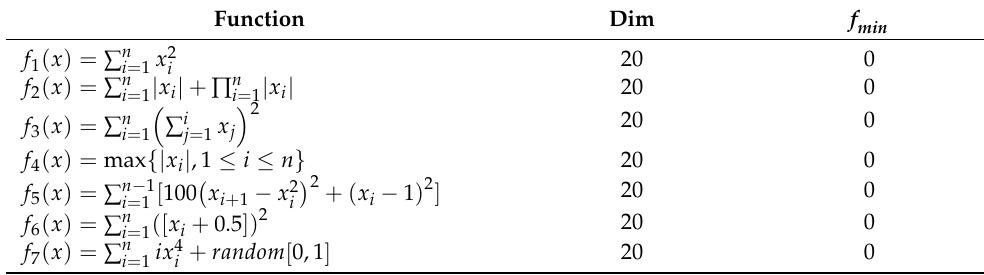
Table 1. Unimodal functions.